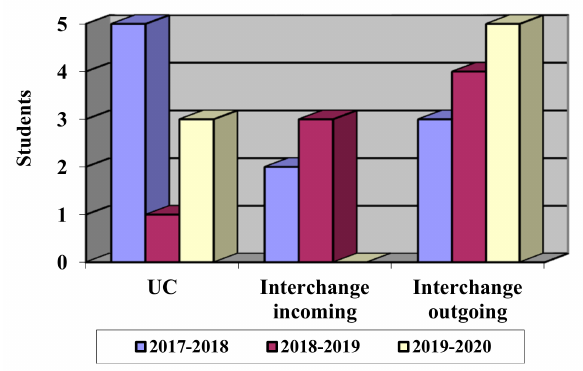
Figure 1. Number and origin of the